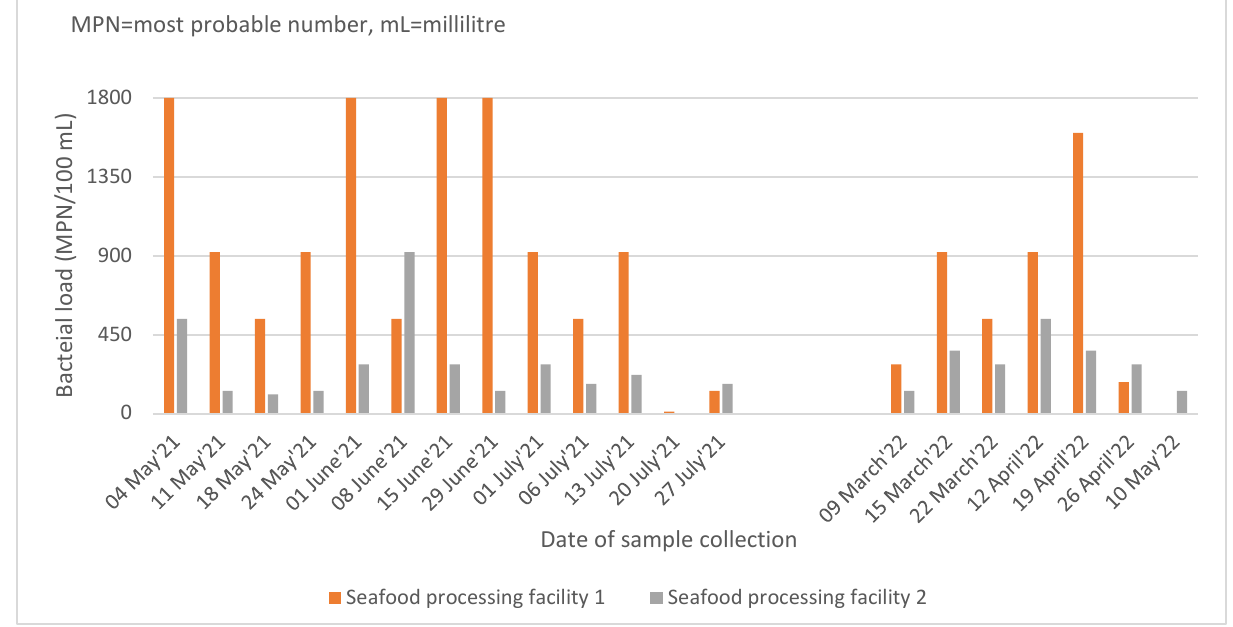
Figure 1. Bacterial load in the effluent samples collected from the two seafood processing facilities in Tema, Ghana during 2021 and 2022.